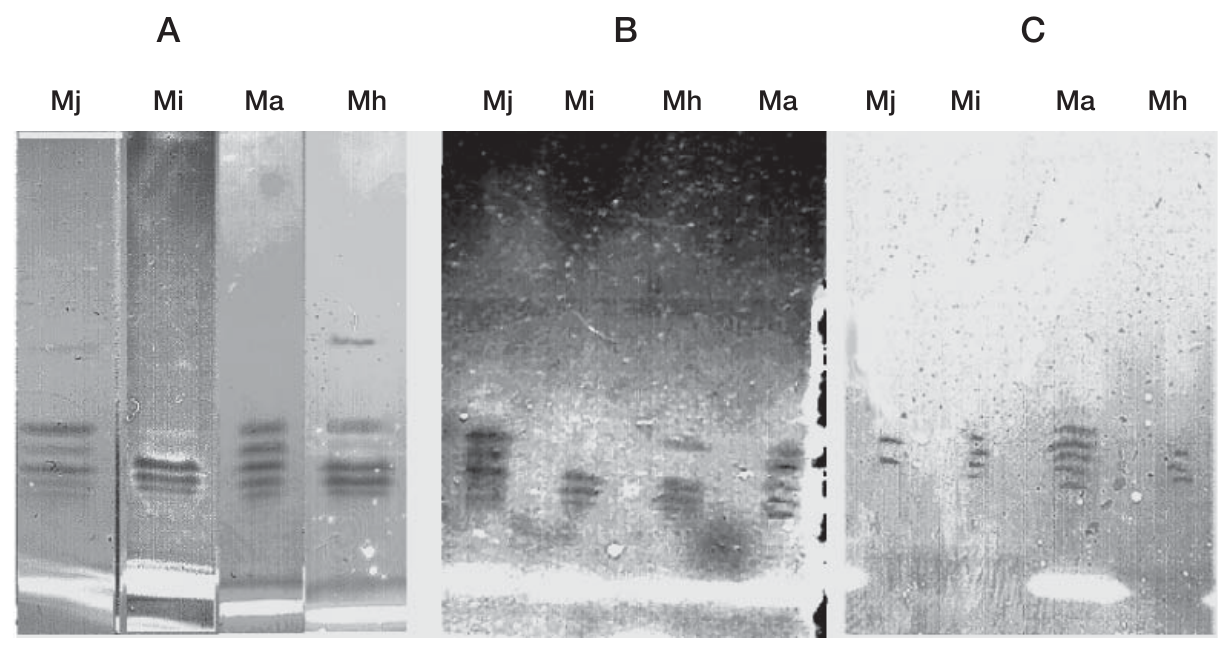
Fig. 2. Native-Page gel of Meloidogyne javanica (Mj), M. incognita (Mi), M. arenaria (Ma), and M. hapla (Mh) samples stained for SOD activity. A, Extracts of females; B, extracts of egg masses; C, extracts of invading